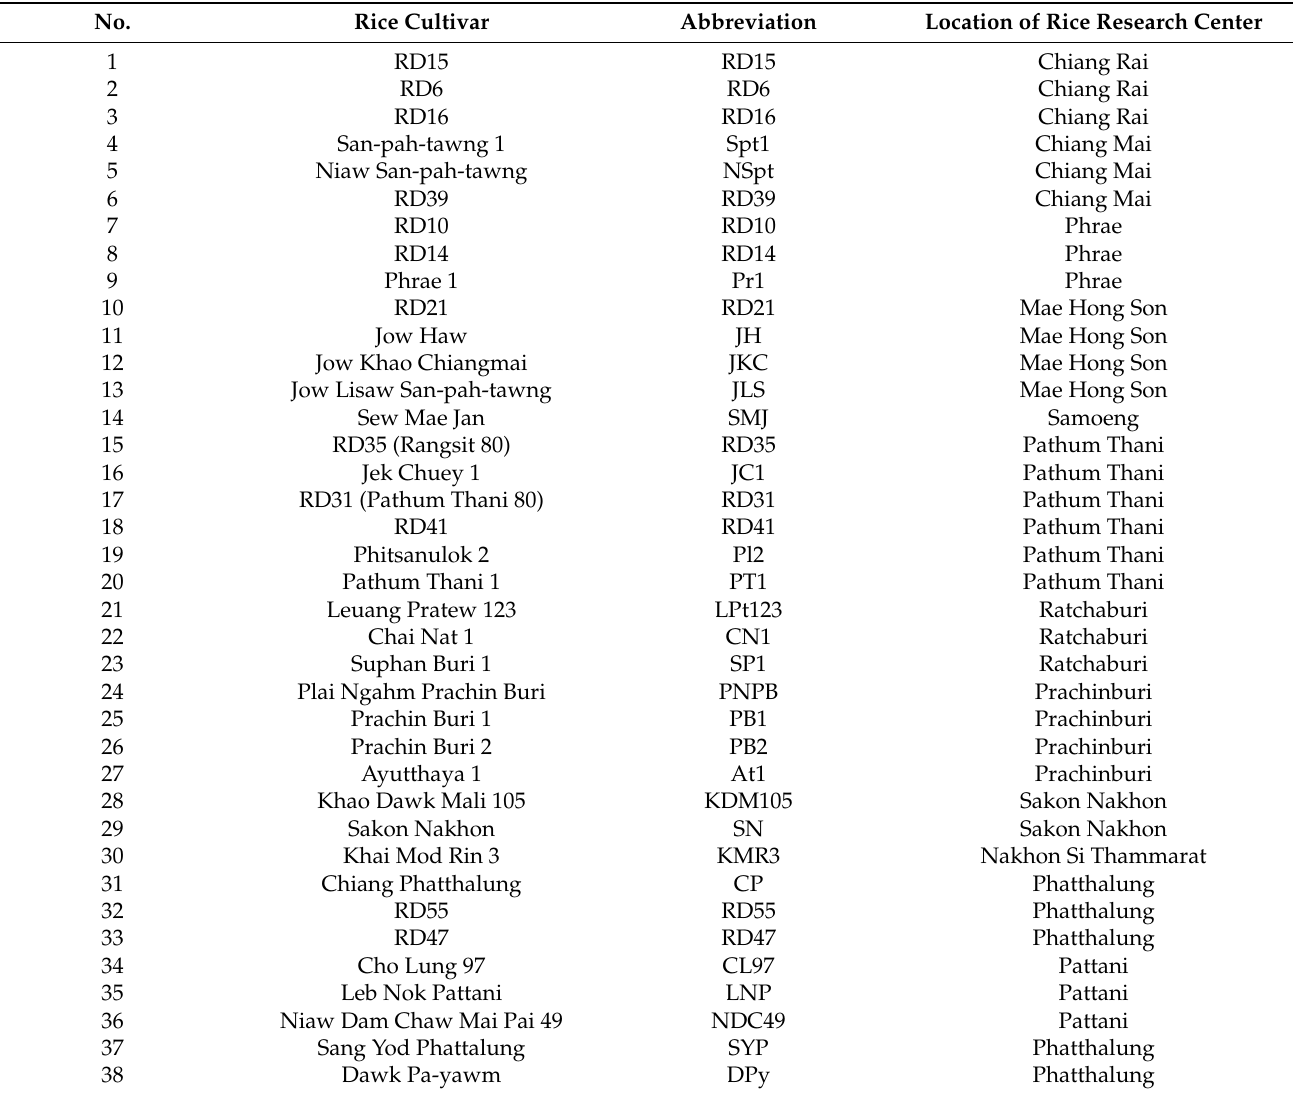
Table 6. List of the 38 paddy-rice cultivars from various rice research